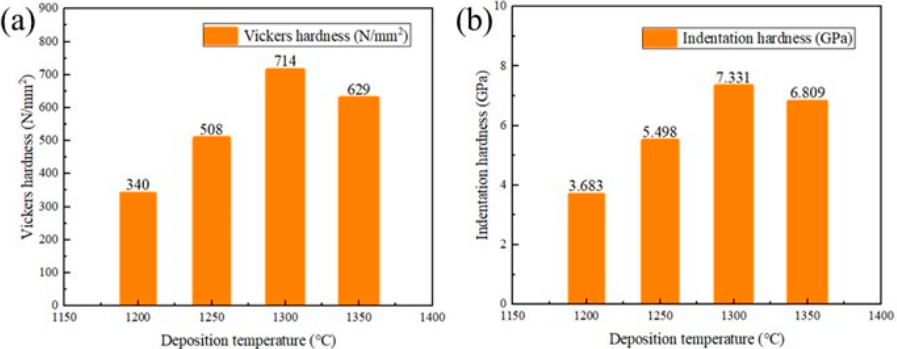
Figure 9. The relationship between deposition temperature and hardness of HfO 2 coatings. ( a ) is Vickers hardness and ( b ) is indentation hardness.